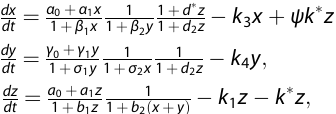
Fig. 3 Realisation of tristability by embedding two bistable sub-systems in hematopoiesis. a Phase plane of the GATA1-PU.1 module showing the bistable property of the proposed model, where A and B are stable steady states; C, D and E are saddle states. b Simulations of GATA-switching of model (5). Upper panel: An unsuccessful switching with a small value of k (cid:3) enough for cells to leave the HSCs state ( Z state); Lower panel: A successful switching with suf fi cient displacement of GATA2 by using a large value of k (cid:3) . Cells leave the HSCs state and enter the U state. c The 3D phase portrait of the modi fi ed embedding model (6) with k * = 0. Four red 0 points are stable steady states, while the three black points are saddle